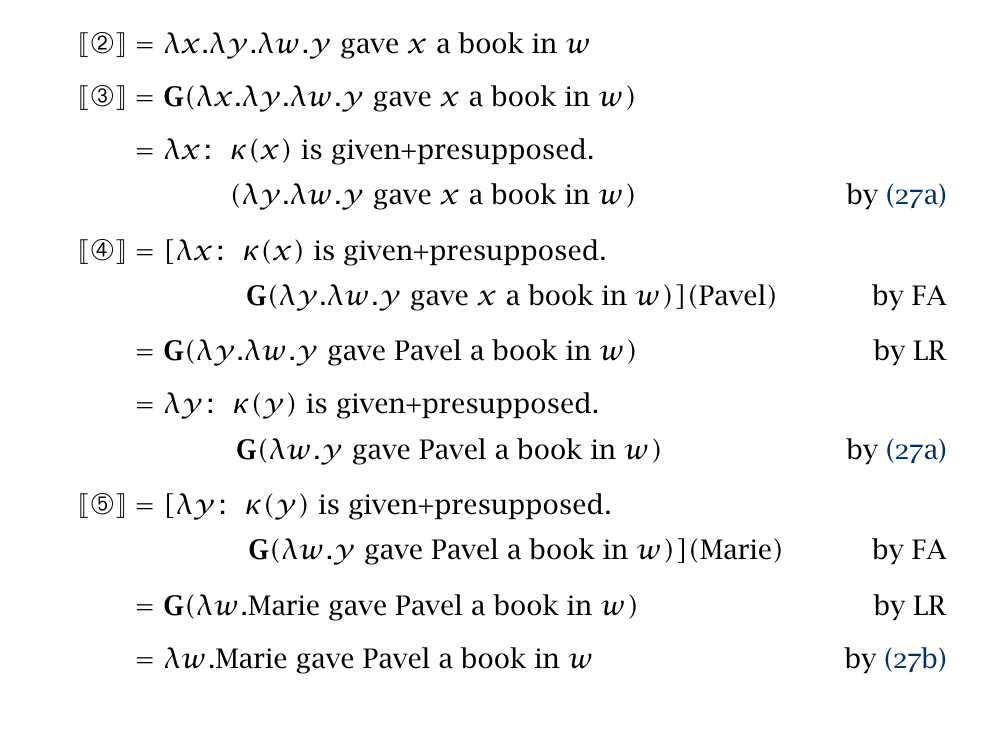
Figure 1 The LF of ( 29 ).